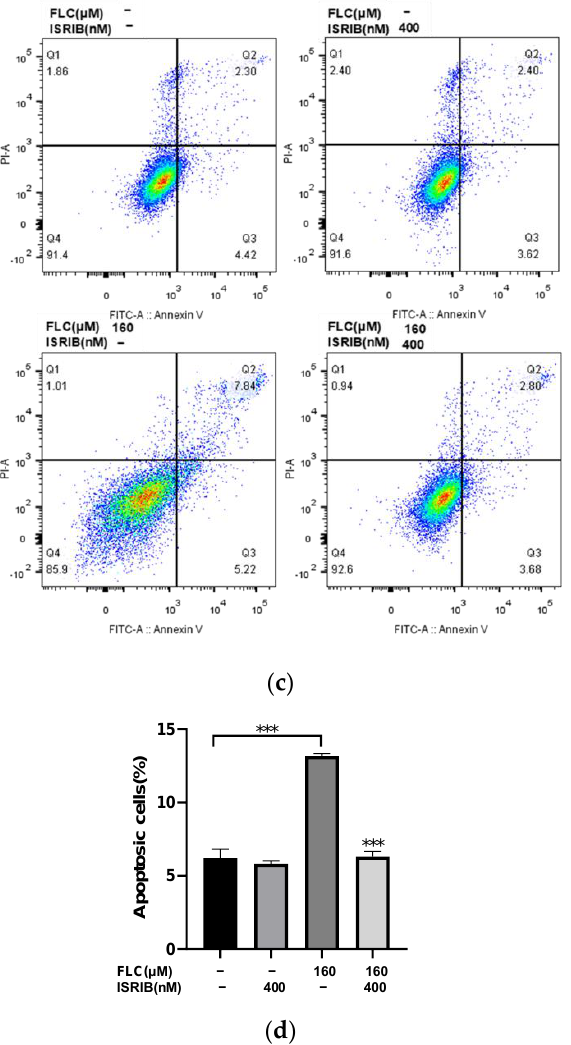
Figure 5. ISRIB alleviated FLC-induced cytotoxicity and apoptosis. TM4 cells were treated by ISRIB at the concentration of 200 and 400 nM for 6 h before treated by FLC at the concentration of 160 μM for 6 h. ( a ) Cell viability was detected by CCK-8 assay ( n = 6); ( b ) Cytotoxicity was detected by LDH leakage assay ( n = 6). Apoptotic cells were determined by flow cytometry; ( c ) The representative images were shown; ( d ) The quantitative data was analyzed by FlowJo and GraphPad Prism software ( n = 3). * p < 0.05, *** p < 0.001, **** p < 0.0001 vs. corresponding group.